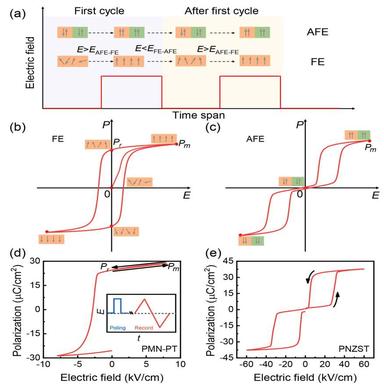
(a) The schematic diagram of microstructure evolution of FE and AFE materials during direct EC measurement. The P-E loops of (b) FE and (c) AFE materials and corresponding microstructure evolution. The P-E loops of (d) PMN-PT single crystal and (e) PNZST AFE ceramic by our designed measurement process, while the inset in (d) is the electric field as a function of time during the process.